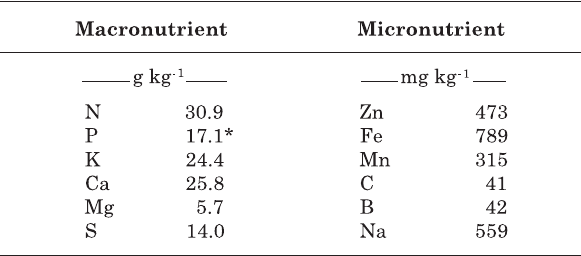
Table 2. Total contents of macro and micronutrients and sodium in poultry litter with wood shavings